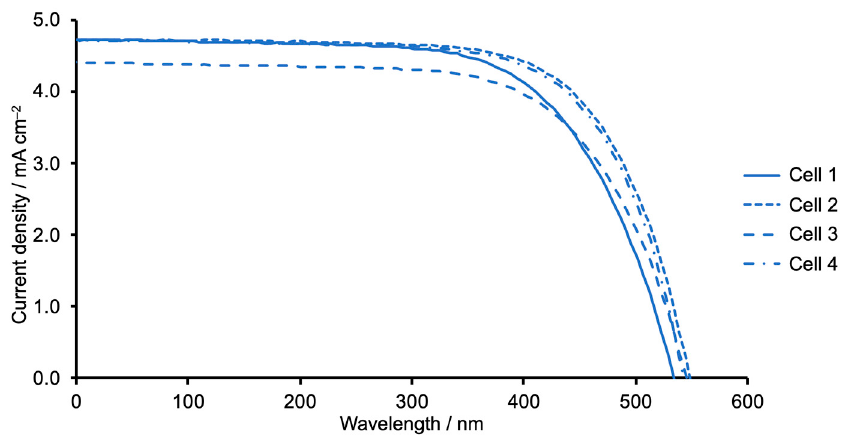
Figure 12. J–V curves for a set of four DSCs sensitized with [Cu( 5 )( 1 )] + with DPA as a co-adsorbent, measured on the day of sealing the cells.